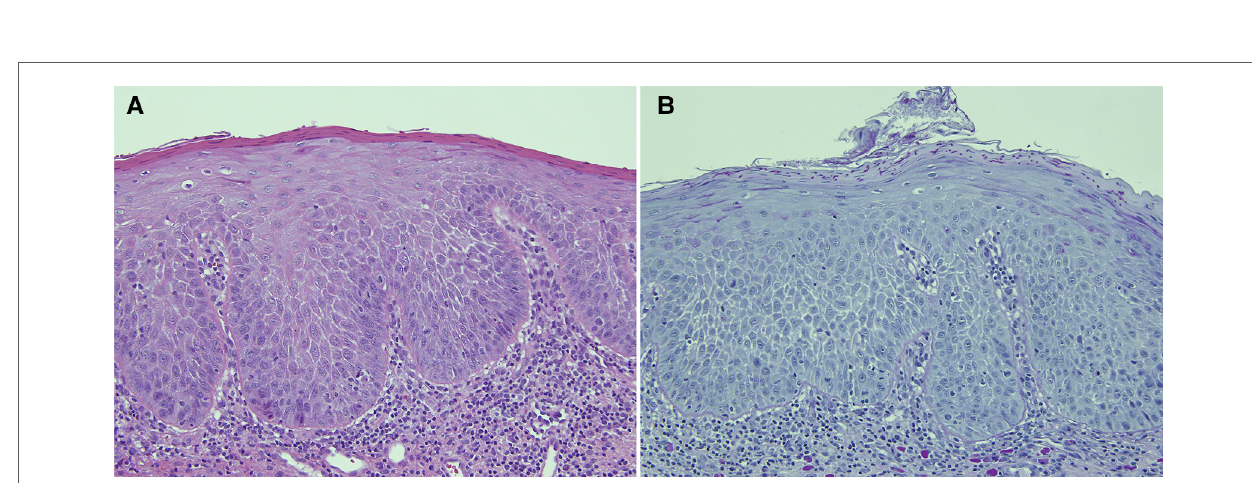
FIGURE 3 Photomicrograph from a biopsy of a white patch on the ventral tongue in a 40 year old female with a clinical provisional diagnosis of oral lichen planus. There is a band-like in fi ltrate of lymphocytes in the lamina propria immediately adjacent to the epithelium and some evidence of basal cell lysis, but the variability of nuclear shape and staining in the basal epithelium in addition to the rounding of the rete ridges means the epithelium is dysplastic and thus the diagnosis of lichen planus is excluded.